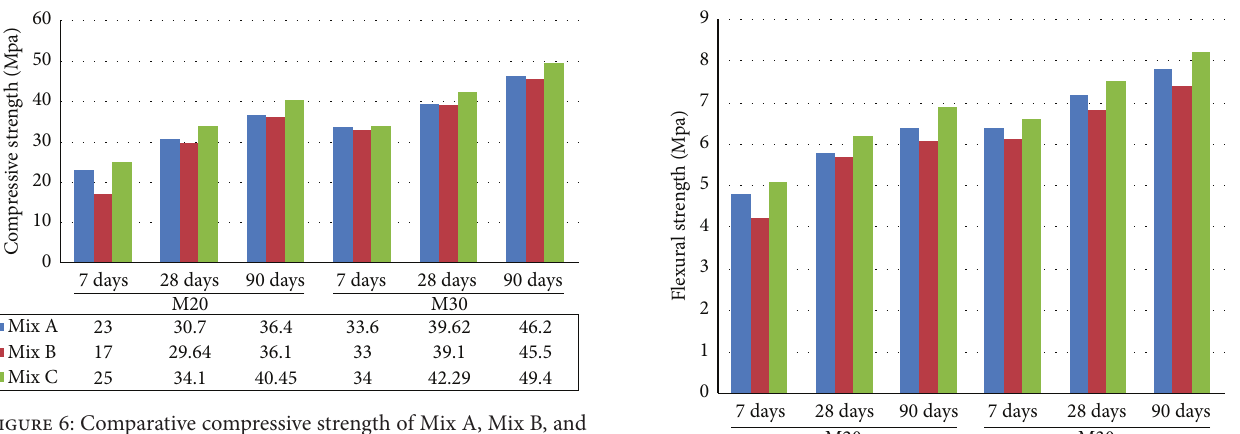
Figure 6: Comparative compressive strength of Mix A, Mix B, and Mix C of M20 and M30 grade.